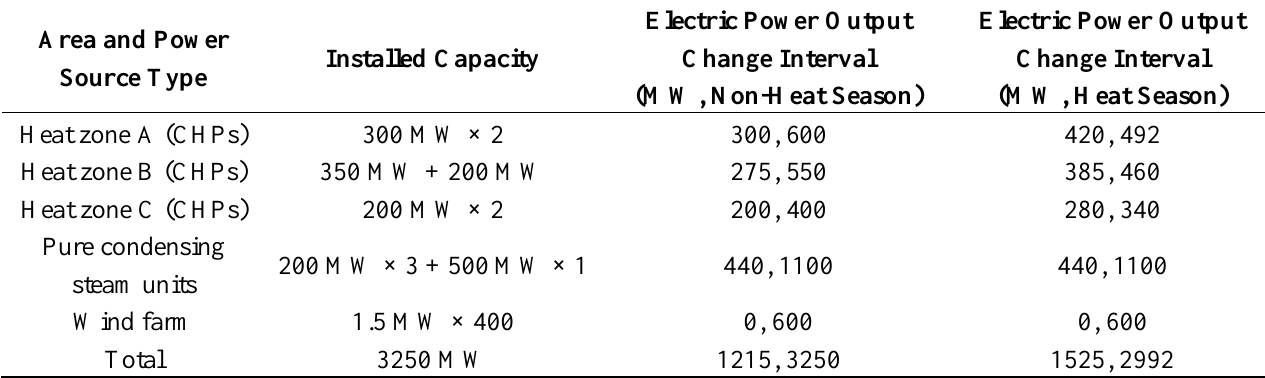
Table 3. The related parameters of the power sources within the simulation region.